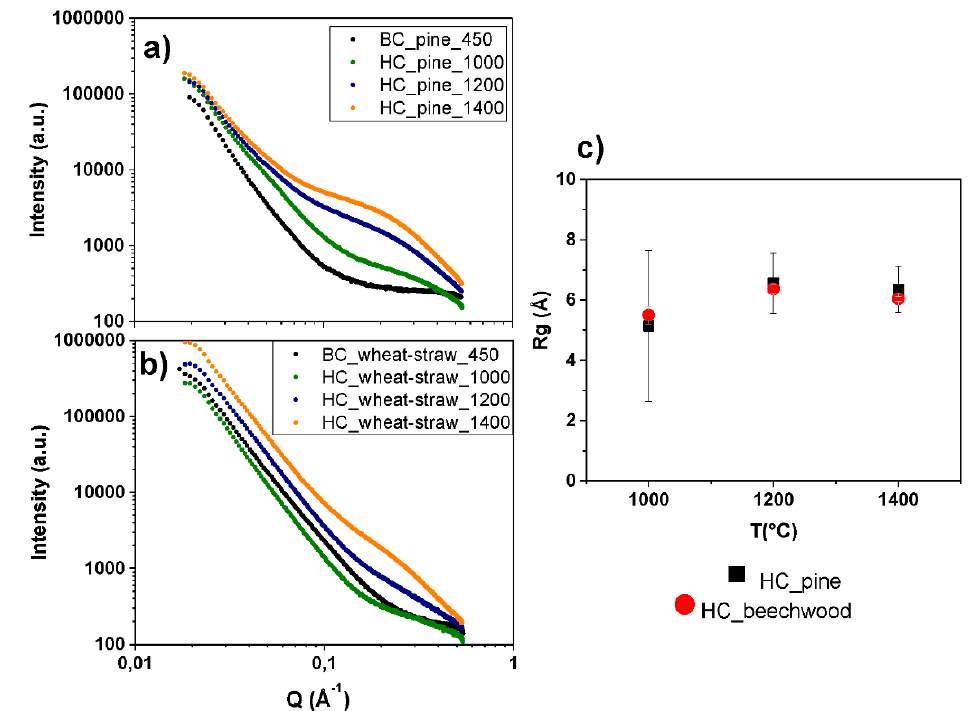
Figure 7. Small Angle X-ray Scattering (SAXS) patterns for ( a ) pine and ( b ) wheat straw derived biochars and hard carbons. ( c ) Radius of gyration of the woody derived hard carbons.